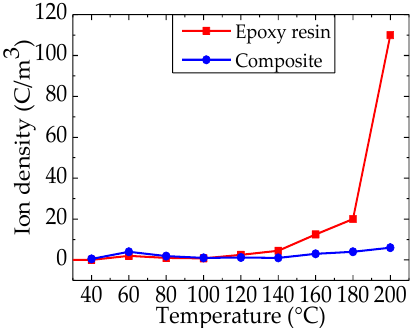
Figure 6. Ion density of epoxy resin and epoxy/nano − SiO 2 /micro − BN composite at varied temperatures.